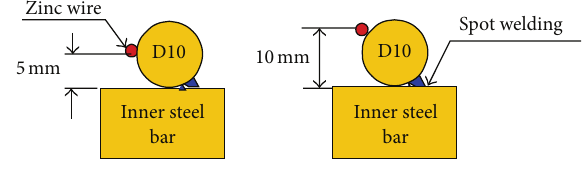
Figure 21: Position of a zinc wire